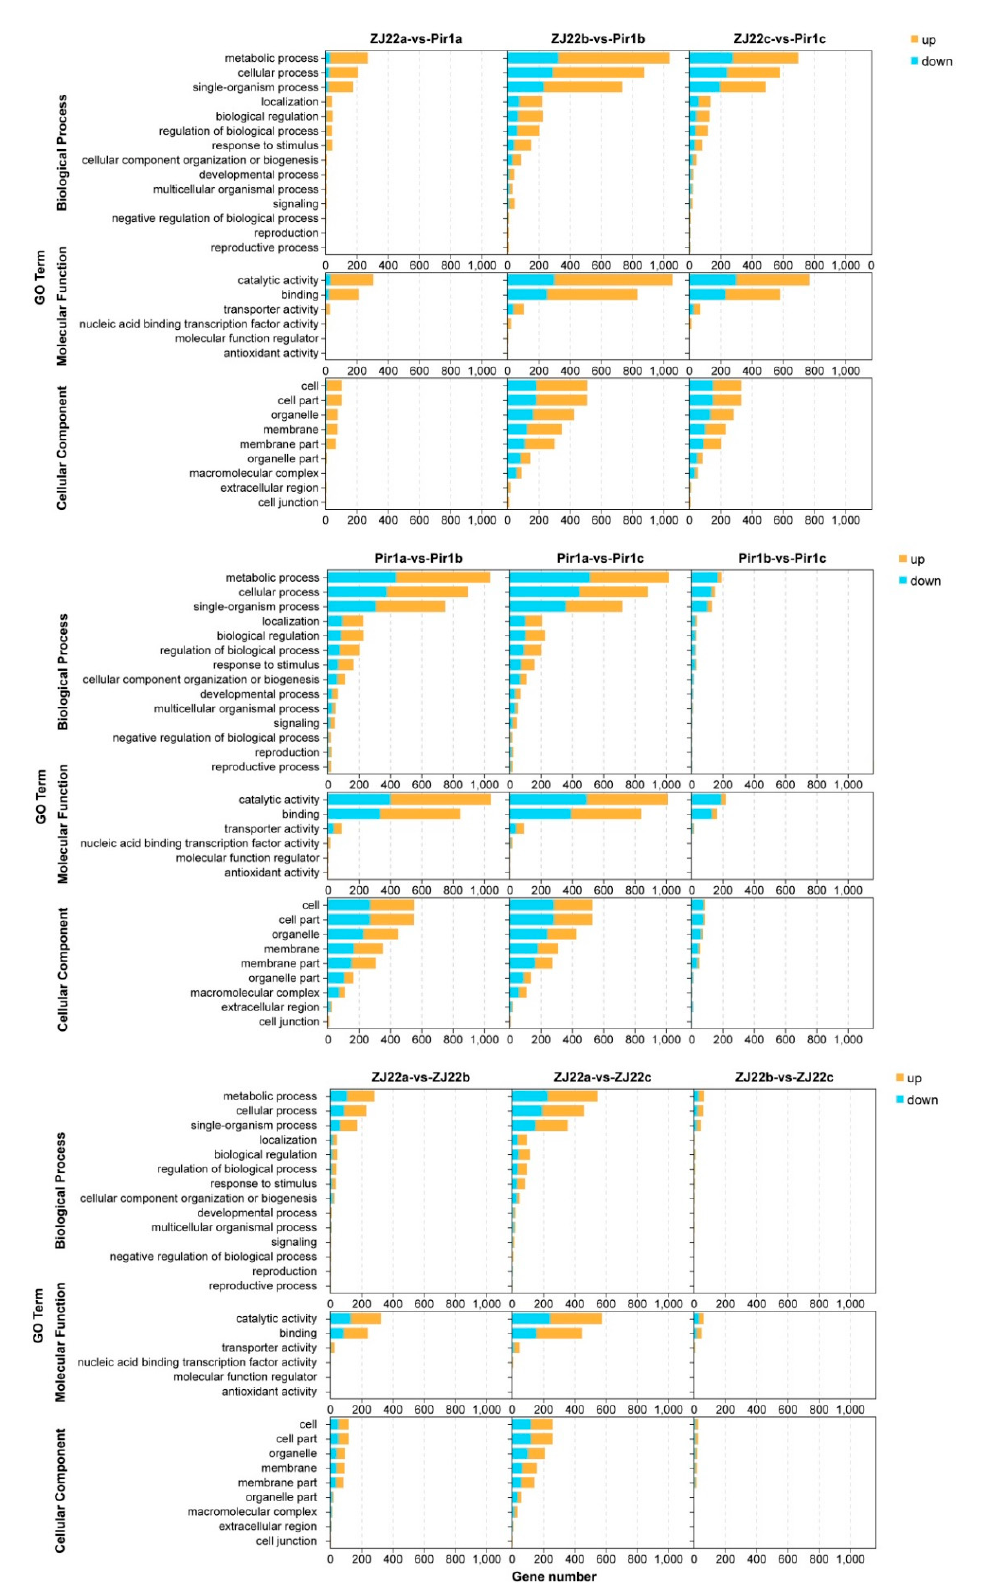
Figure 7. Summary of the distribution and number of DEGs in the three ontology classes, molecular function, cellular component, and biological process.